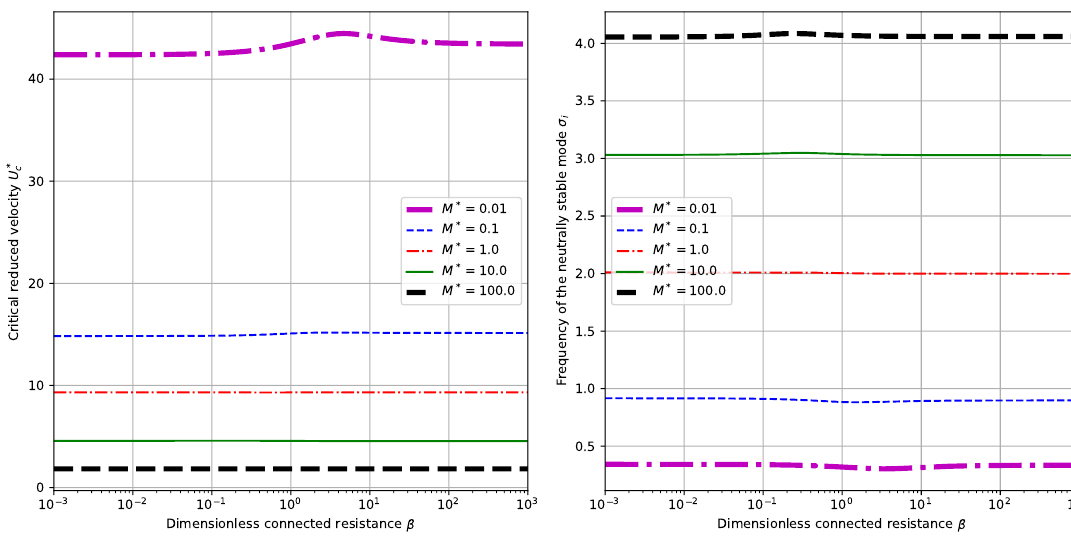
Figure 7. Dependence of critical reduced velocity U ∗ c and neutrally stable frequency σ i upon the externally connected resistance β and different values of M ∗ . (Here we have α = 0.5).